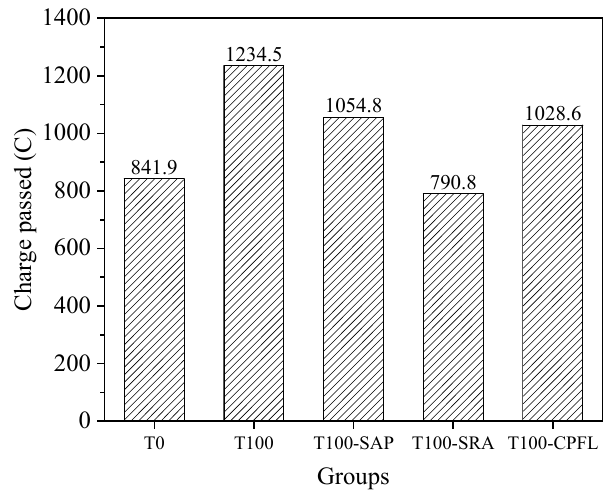
Figure 13. Resistance to chloride penetration of concrete with iron tailings sand and river